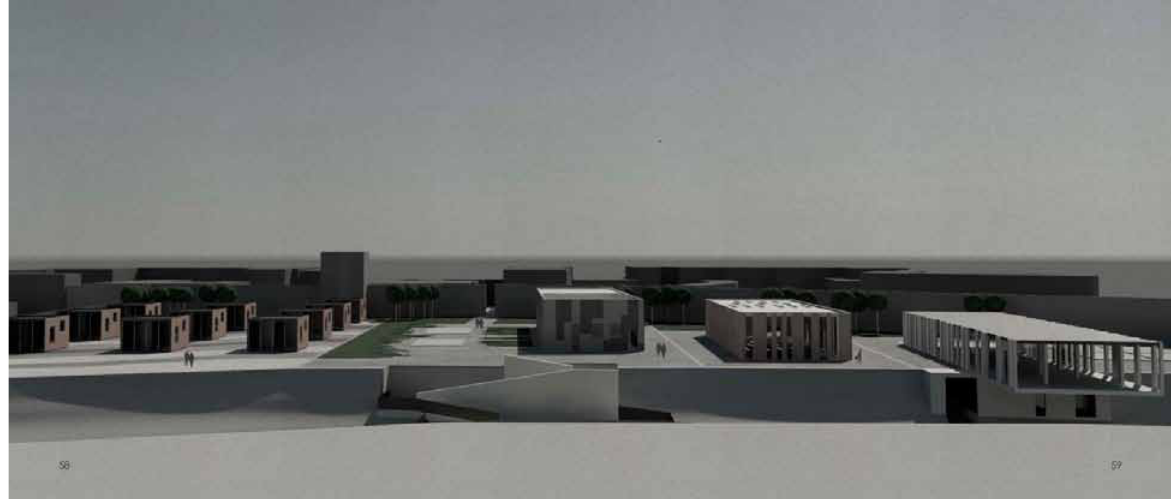
fig. 4. View from the other side of the river of the study area (Pazzato